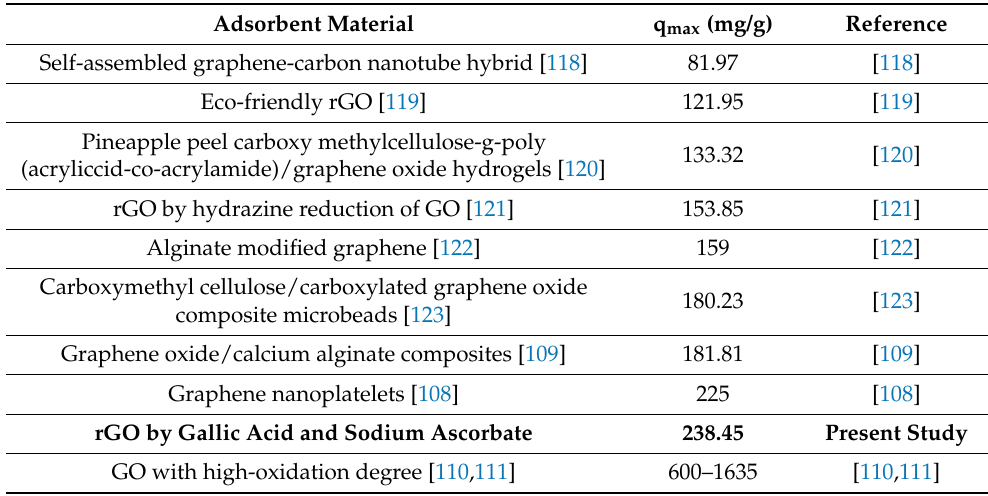
Table 4. Comparison of adsorption capacity of MB ( q max , mg/g) of rGO with other graphene adsorbents.